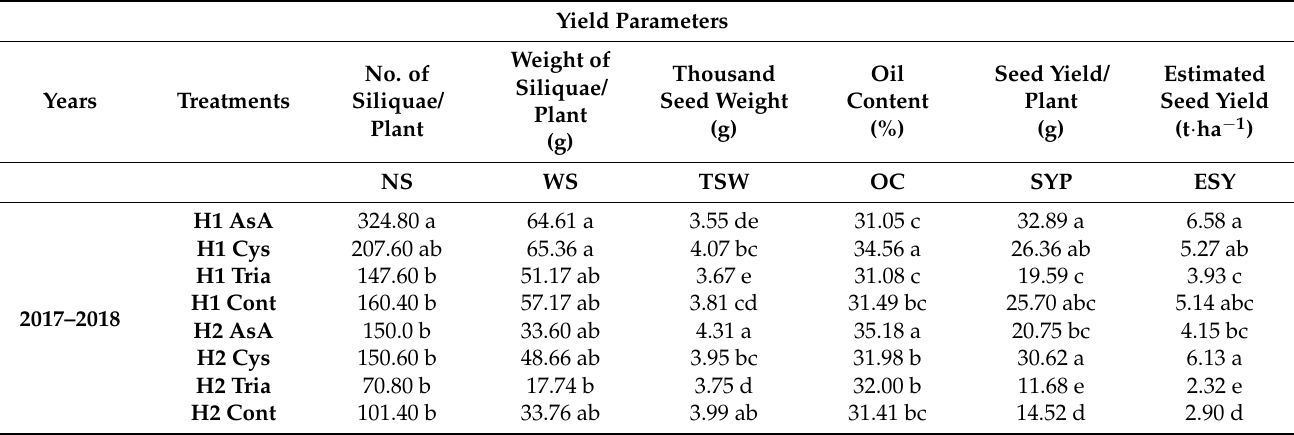
Table 9. Effects of seed priming and foliar treatment with bioactive substances on yield parameters of canola at harvest time (between the years